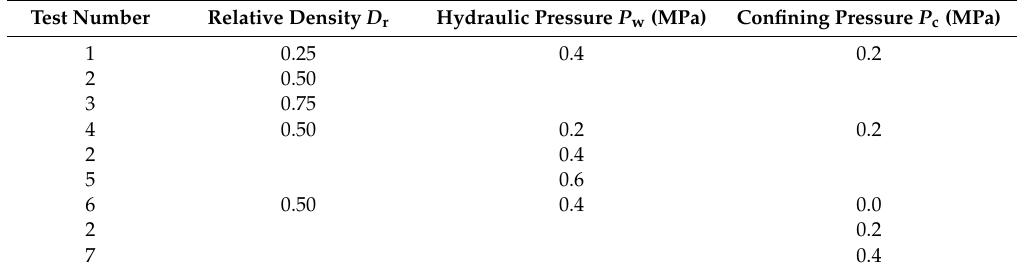
Table 2. Experiment